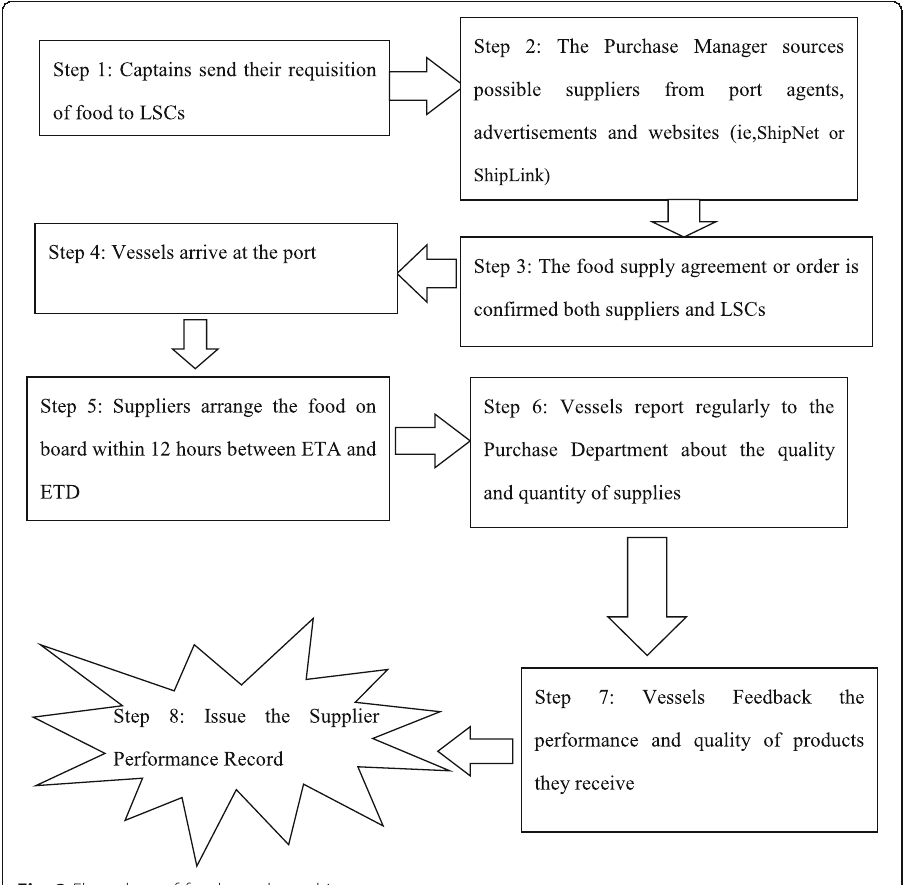
Fig. 3 Flow chart of food supply to